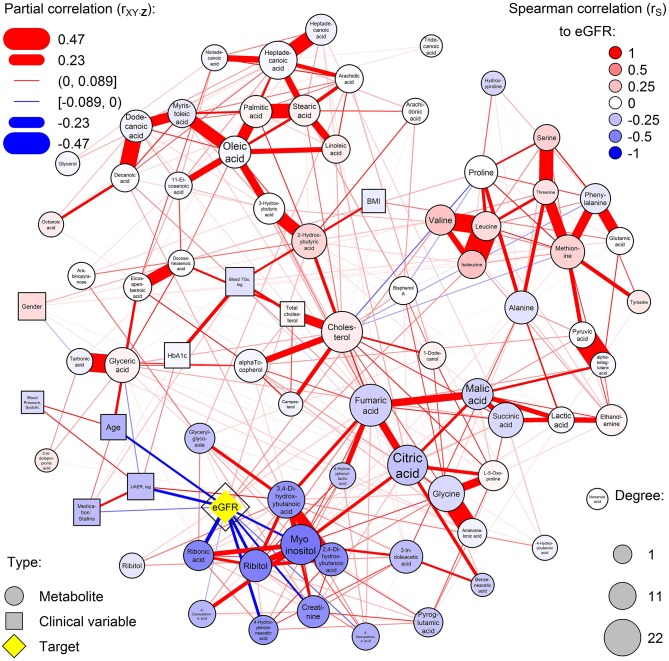
Partial correlation network of serum metabolites and clinical covariates. Nodes are measured variables and edges (lines) are inferred associations (width: strength; color: sign). Circular and rectangular nodes, respectively, are metabolites and clinical variables. Node size is the degree of the node (number of associations with the node). The highest-degree clinical node is highlighted in yellow and other nodes are colored by the respective Spearman correlation to the yellow node (red and blue for positive and inverse correlation, respectively). Blue color represents increased levels of the metabolites with deteriorating kidney function.